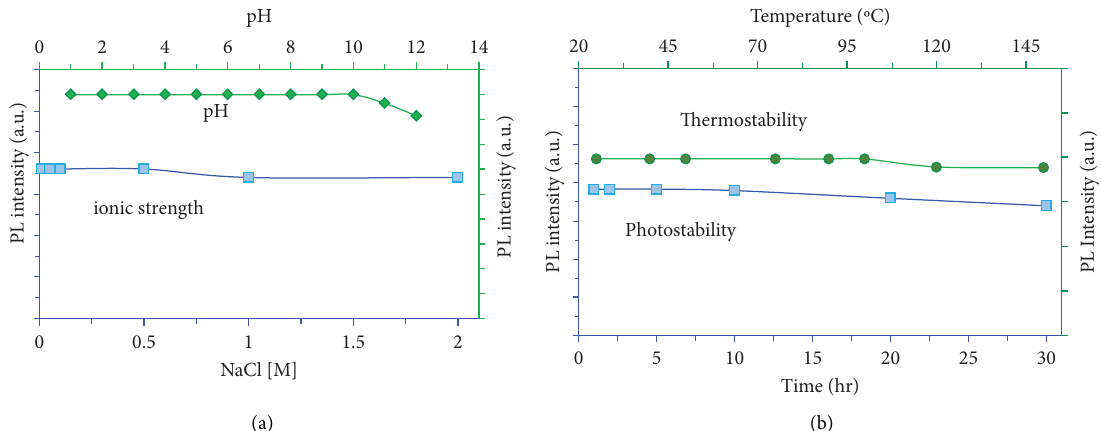
Figure 5: (a) Efects of pH and ionic strength on the intensity of HP-CQDs. (b) Efects of temperature and radiation on the intensity of HP-